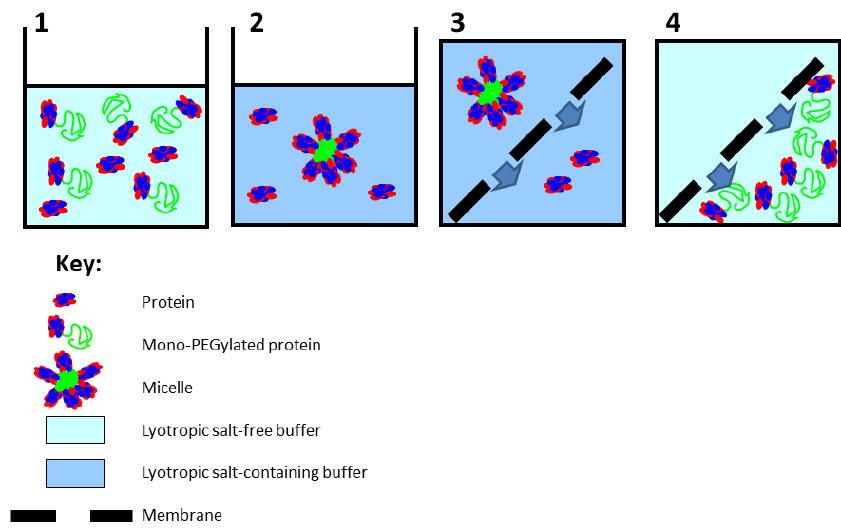
Figure 1. Steps involved in hybrid purification of PEGylated protein.